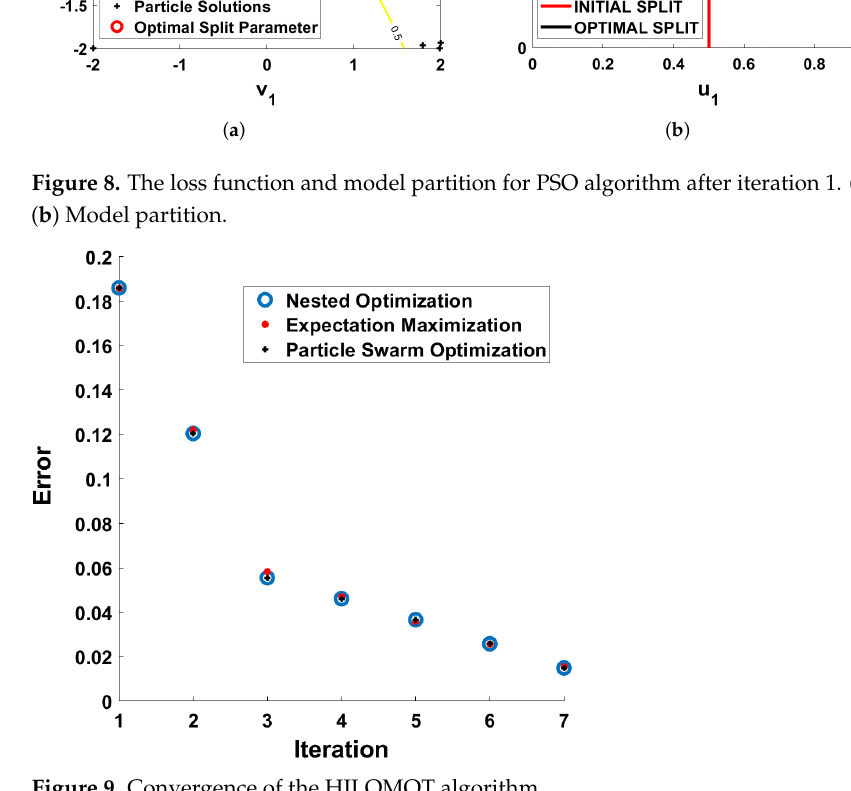
Figure 9. Convergence of the HILOMOT